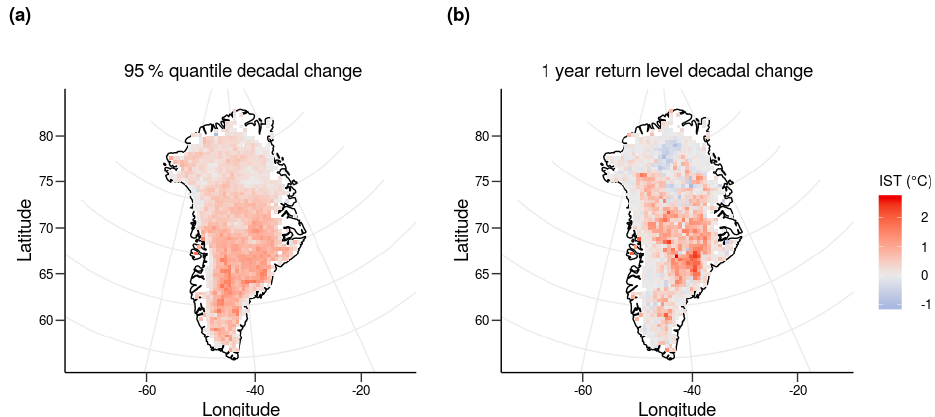
Figure 8. Comparison of the change in 95% quantiles (a) and 1-year return levels (b) of mixture models fit to MODIS IST data from 2001 to 2009 and 2010 to